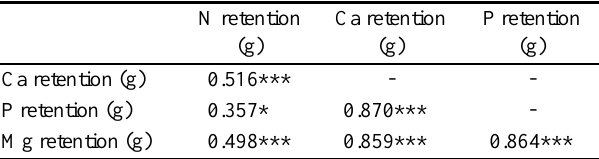
Table 5. Correlations (r, p-value) between N, Ca, P and